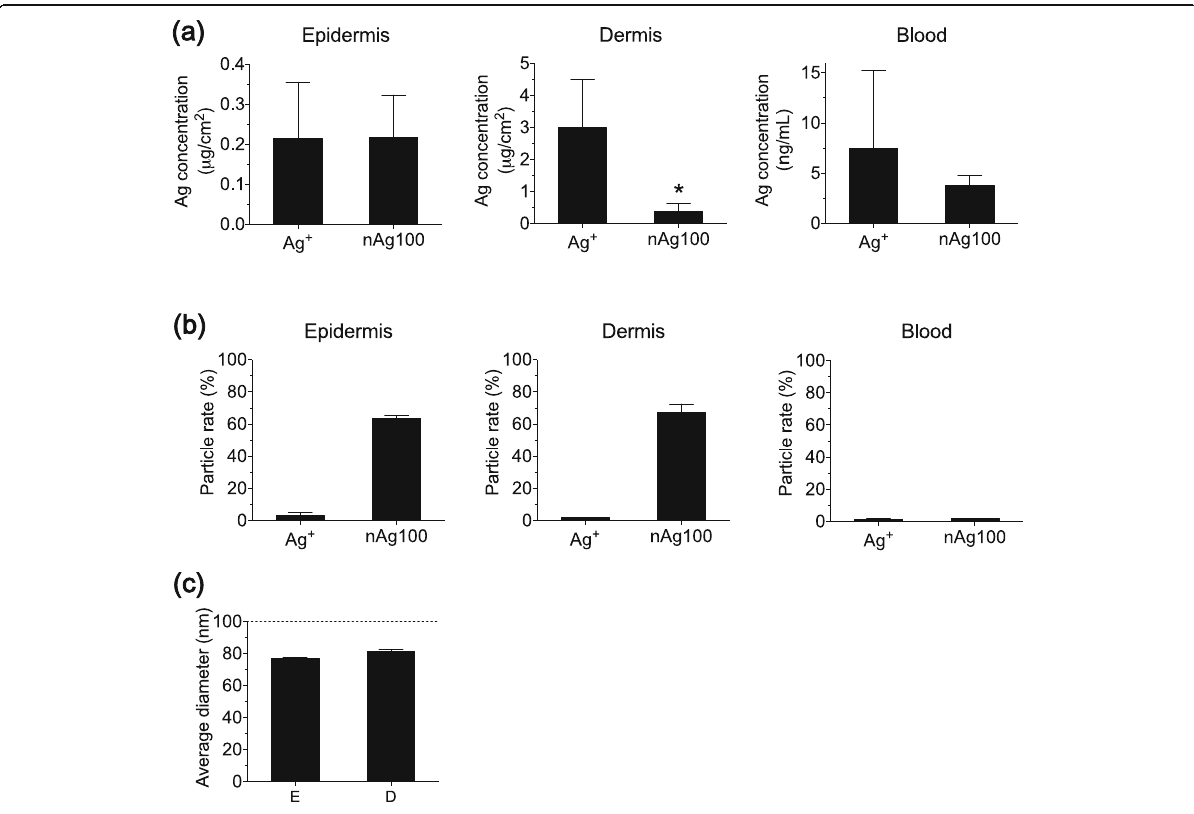
Fig. 4 Semi-quantitative physical property analysis of nAg100 and Ag + applied to mouse skin in vivo. Firstly, mouse skin was exposed to nAg100 and Ag + (20 μ g Ag/cm 2 ). Five days after exposure, quantification, and evaluation of physical properties of Ag in epidermis, dermis, and blood were conducted via ICP-MS and sp-ICP-MS, respectively. a Ag concentrations and b particle rates detected in the epidermis, dermis, and blood. c The average diameter of particles detected in the epidermis and dermis. The dashed line represents the initial particle size. All data have been expressed as mean ± S.E. ( n = 3). * p < 0.05 (Student ’ s t